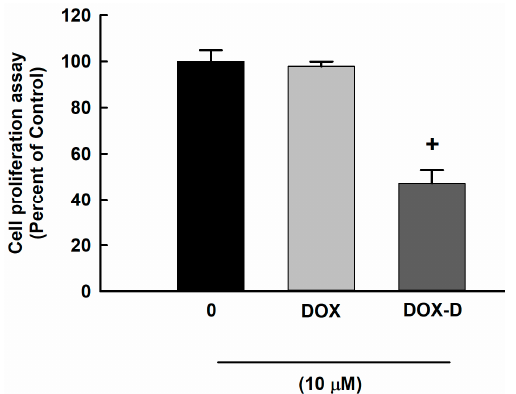
Figure 3. Effect of DOX and DOX-Vit D on MG63 cells proliferation. MG63 cells were exposed to 10 µM DOX and DOX-Vit D for 24 h. Thereafter, the cell proliferation was determined using MTT assay. The results are presented as the mean ± SEM ( n = 6). + p < 0.05 compared to control.